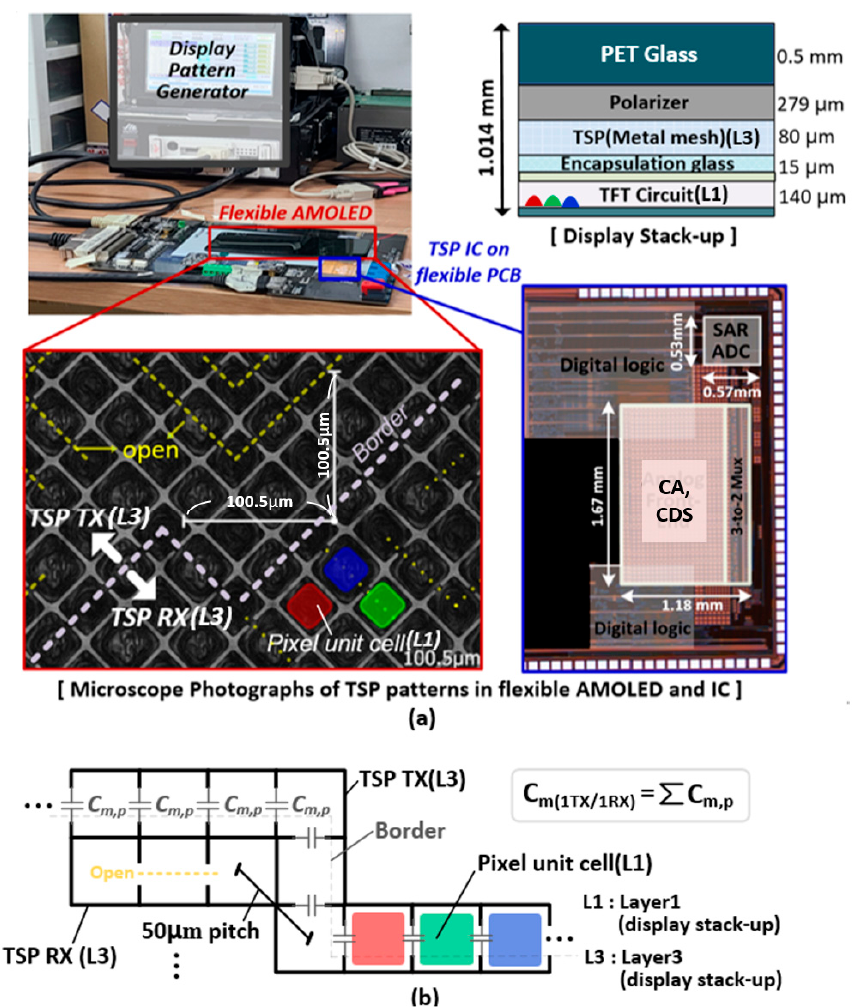
Figure 15. ( a ) Measurement environment and micrographs of TSP and IC, and ( b ) overall diagram of metal-mesh TSP with display pixel.